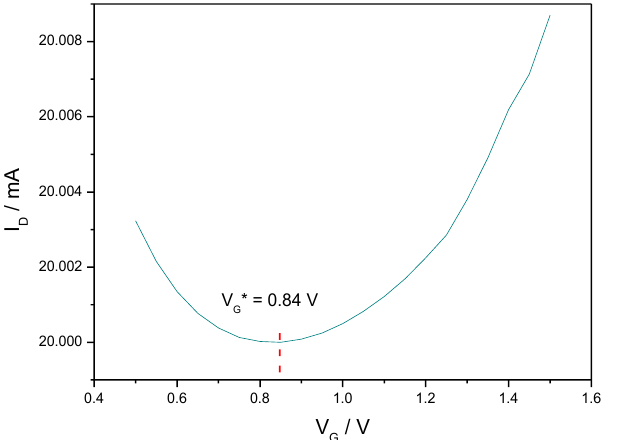
Figure 3. Typical transfer characteristic recorded for V D = 0.9 V on an inkjet-printed rGO EGGFET, with a gate diameter of 1 mm (area of 7.85 × 10 −3 cm 2 ) and an rGO area of 5 × 10 −3 cm 2 . V G * = 0.84 V. Electrolyte: PBS. T = 25 °C.